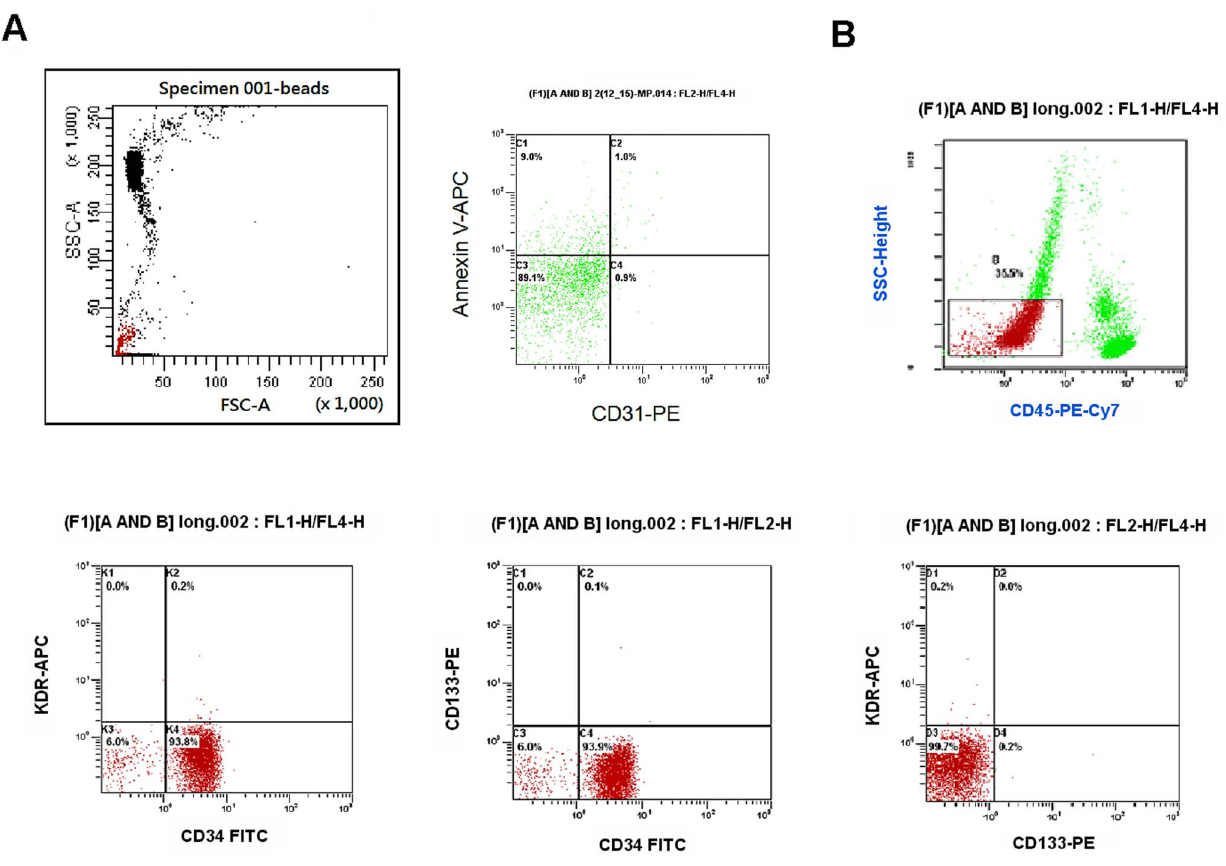
Figure 1. Representative flow cytometry analysis for quantifying the number of endothelial progenitor cells and endothelial microparticles. (A) The gate was set using sizing microparticles ( , 1.5mm). Endothelial apoptotic microparticles were defined as particles positively labeled for CD31 and annexin V (CD31 + /annexin V + ). (B) Mononuclear cells (MNCs) were gated by forward/sideward scatter (FSC/SSC). The numbers of circulating endothelial progenitor cells (EPCs) were gated with monocytes and defined as CD34 + KDR + CD133 + . FITC, fluorescein isothiocyanate.